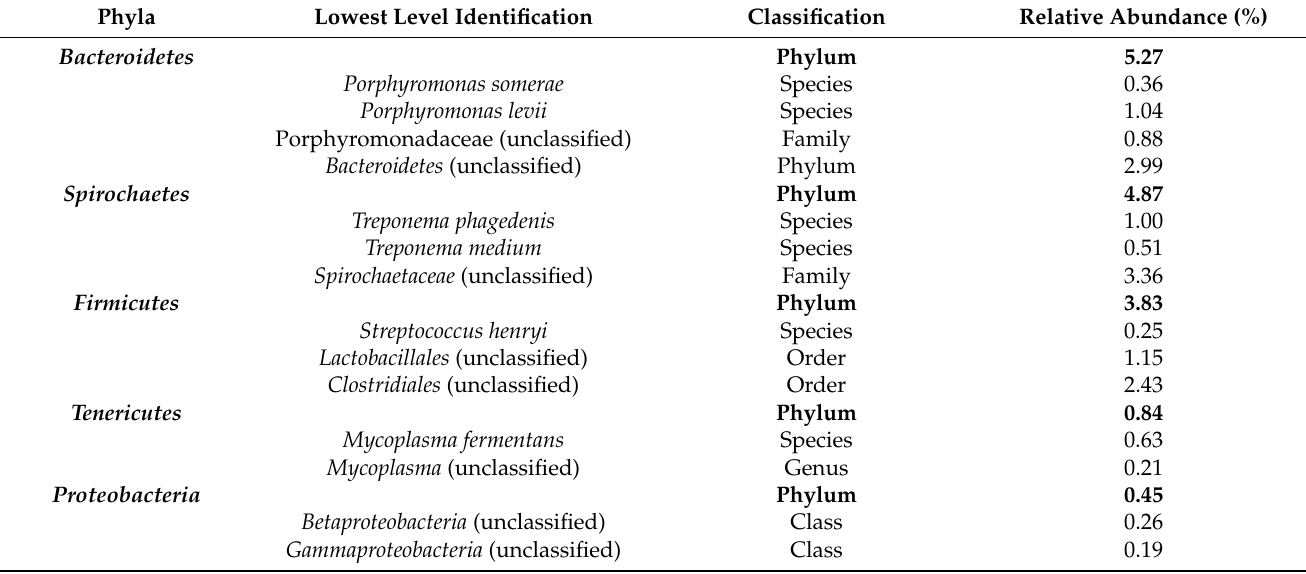
Table 1. Relative abundances of bacterial taxa with ≥ 80% complete genome identified in digital dermatitis lesions. These bacterial taxa account for 15.26% of the total bacterial taxa detected in the sample.